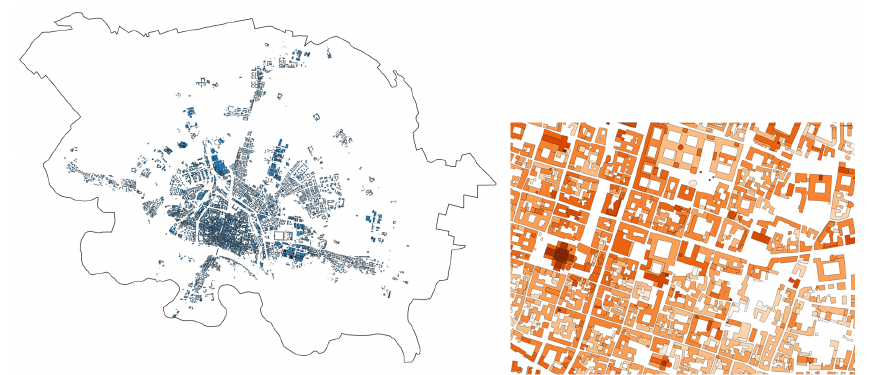
Figure 2. Conceptual representation of the method.